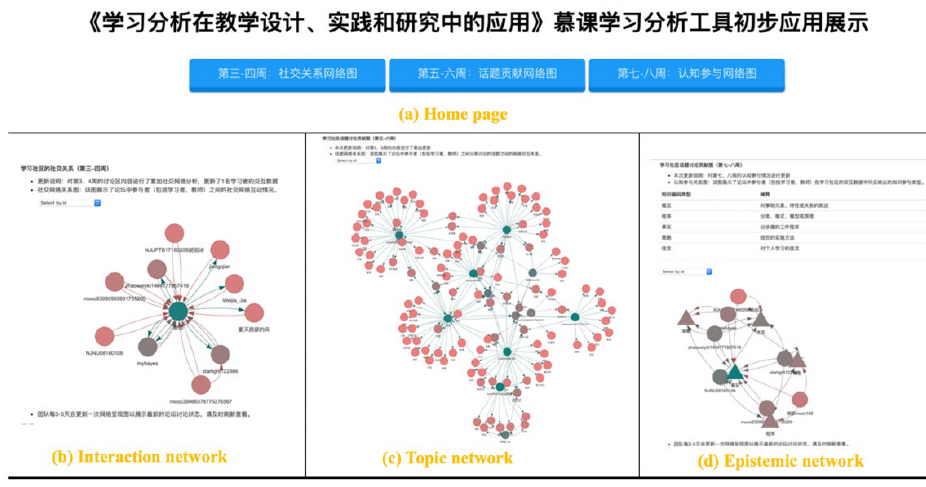
Figure 2 . The learning analytics tool. From “An Application of a Learning Analytics Tool in MOOC,” Fan Ouyang research team, n.d. (https://8jrscl.coding-pages.com/). In the public domain.